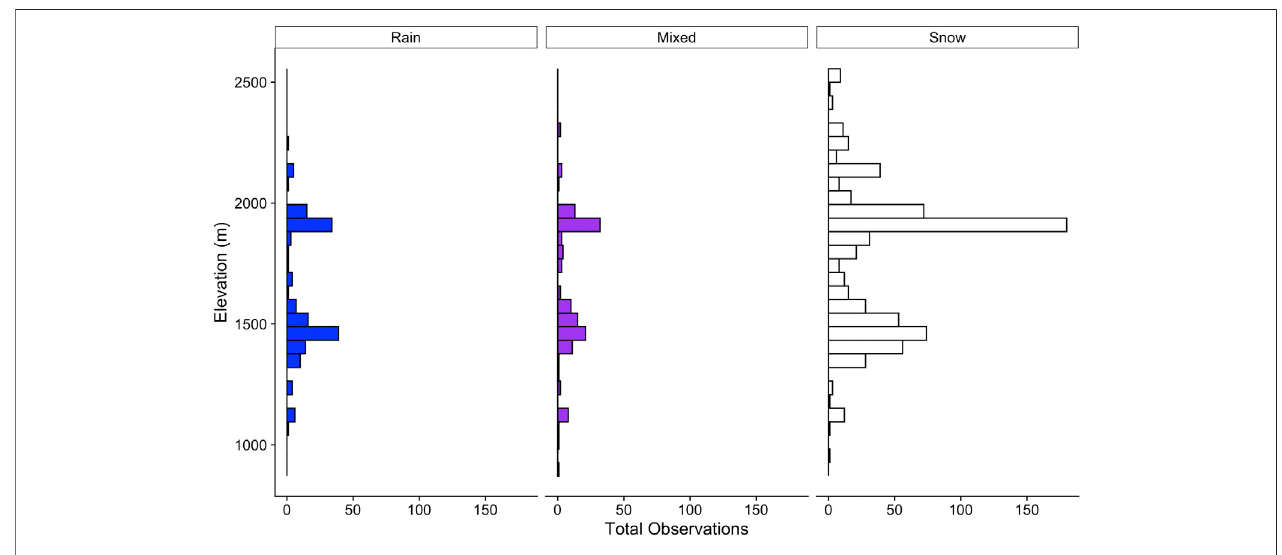
FIGURE 6 | Number of observations by precipitation phase and elevation.